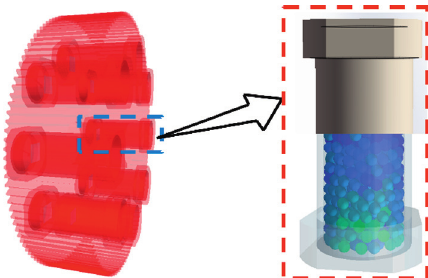
Figure 9: Damper model.